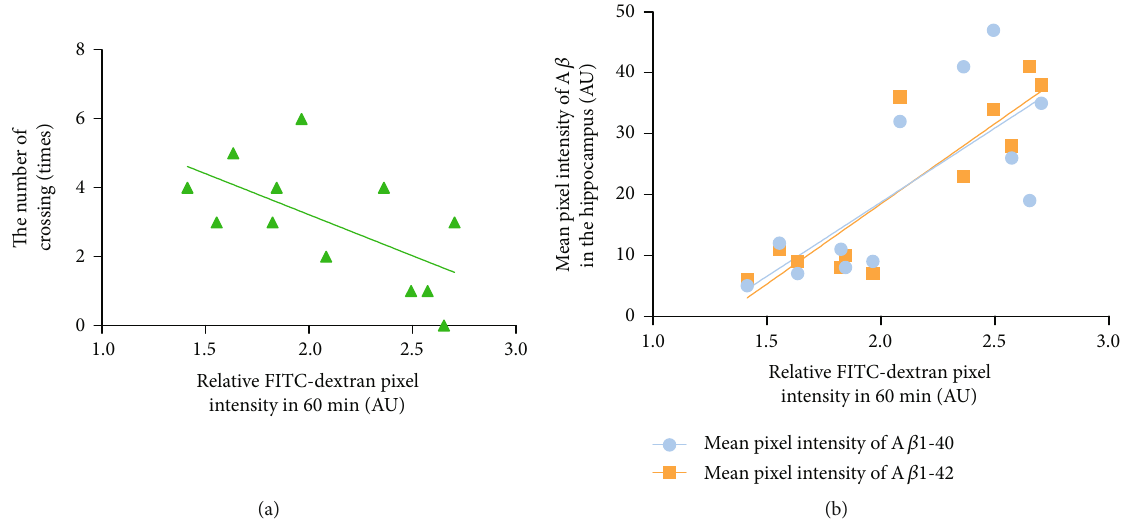
Figure 5: Correlation scatters plot of accelerated glymphatic clearance, improved cognitive function, and reduced A β deposition in APP/ PS1 mice. (a) Correlation between relative FITC-dextran pixel intensity at 60 min and the number of crossings in the MWM task ( r = − 0 : 6707 , P < 0 : 05 ). (b) Correlation between relative FITC-dextran pixel intensity at 60 min and the mean pixel intensity of A β 1-40/ A β 1-42 in the hippocampus ( r = 0 : 8671 , P < 0 : 01 for A β 1-40; r = 0 : 7532 , P < 0 : 01 for A β